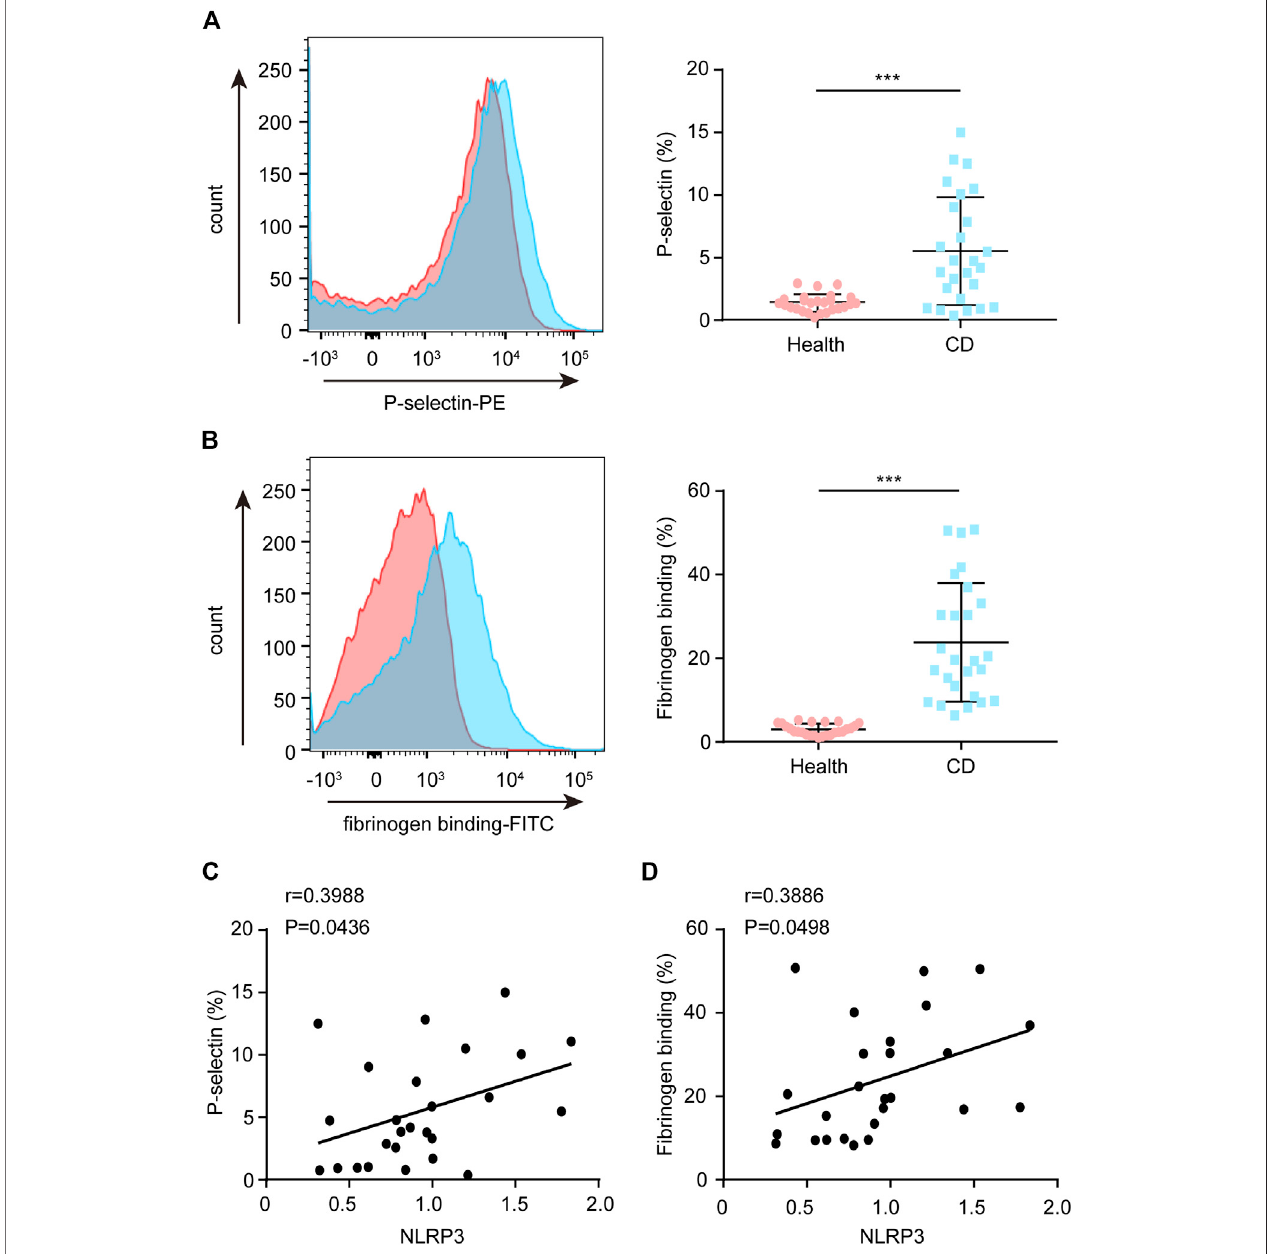
FIGURE 5 | Correlation between the platelet NLRP3 protein levels and P-selectin exposure or fi brinogen binding in patients with active Crohn ’ s disease (CD). (A) P-selectin exposure was assessed by FCM in platelets from the healthy group ( n (cid:2) 26) and patients with active CD ( n (cid:2) 26). The relative quanti fi cation was at right. (B) FibrinogenbindingwasmeasuredbyFCMinplateletsfromthehealthygroup( n (cid:2) 26)andpatientswithactiveCD( n (cid:2) 26).Therelativequanti fi cationwasatright. (C) The NLRP3 protein levels were positively correlated with P-selectin exposure in platelets from patients with active CD ( n (cid:2) 26). (D) The NLRP3 protein levels were positively correlated with fi brinogen binding in platelets from patients with active CD ( n (cid:2) 26). Health, the healthy group; CD, the patients with active CD. Data are presented as mean ± SD, *** p < 0.001.